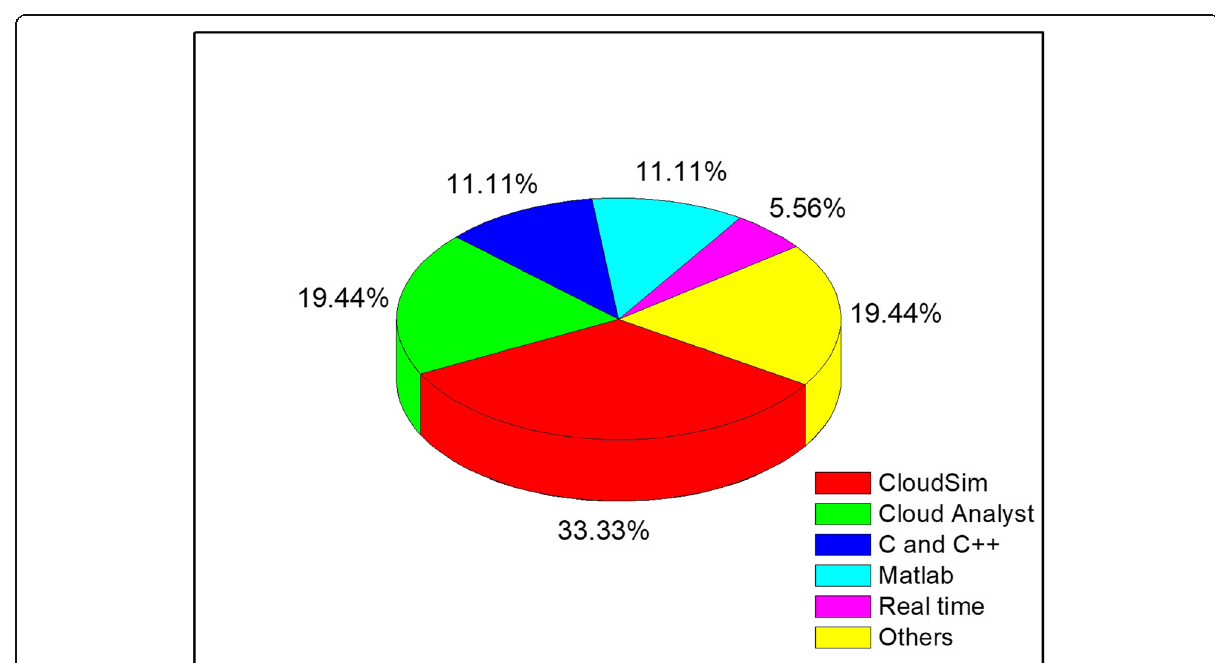
Fig. 11 Experimental platforms for cloud load balancing approaches